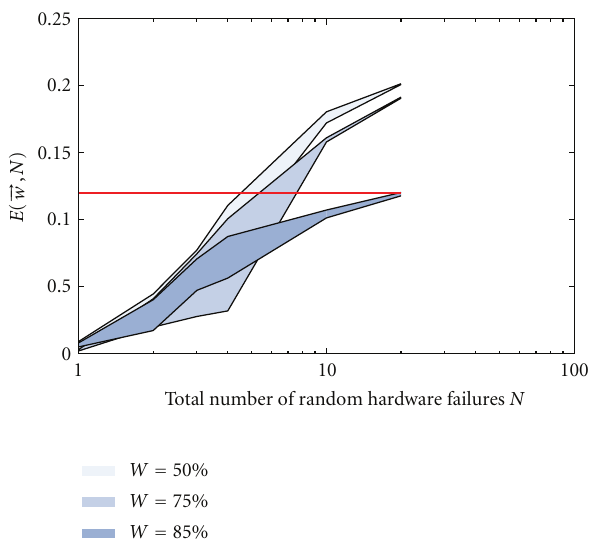
Figure 10: Design space exploration of DFHS for di ff erent allowed amount of hardware